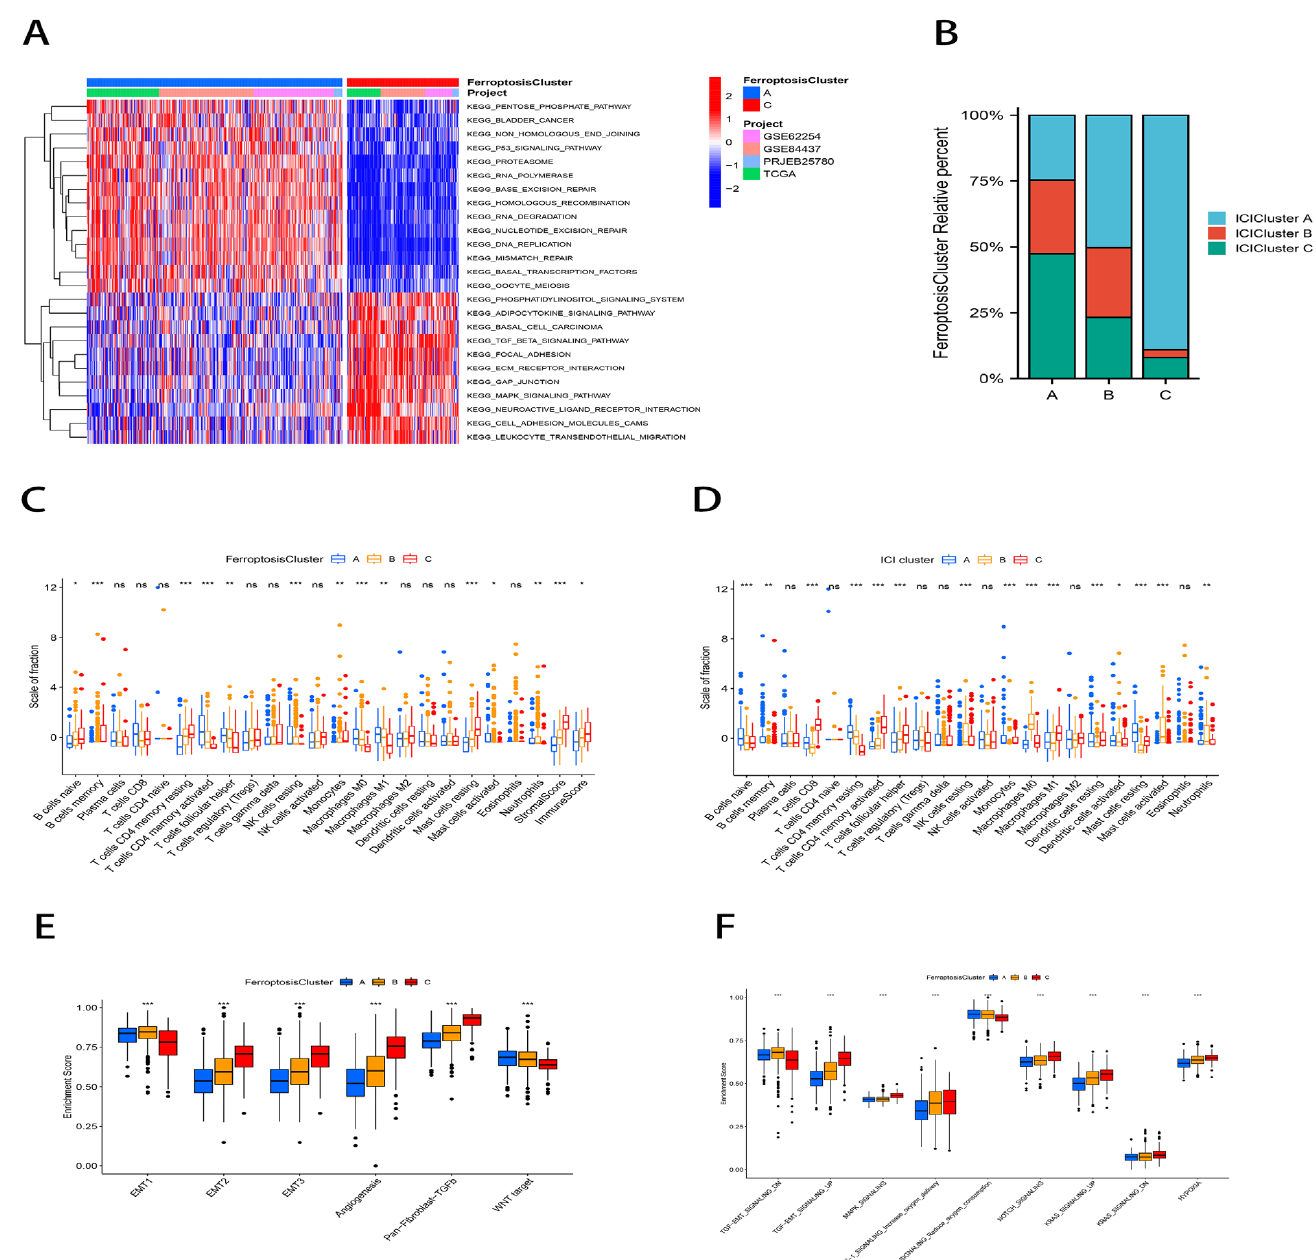
Figure 2. Tumor microenvironment characteristics of ferroptosis molecular subtypes. ( A ) GSVA analysis of distinct biological pathway activation in ferroptosis clusters A and C. Blue represents the repression pathway and red represents the activation pathway. ( B ) Percentage distribution of immune cell infiltration subtypes in each ferroptosis molecular subtype. ( C , D ) Box plots of immune infiltration levels in ferroptosis molecular subtypes ( C ) and immune cell infiltration subtypes ( D ). ns: not significant; * p < 0.05; ** p < 0.01; *** p < 0.001. ( E , F ) Differences in stromal activation pathway ( E ) and carcinogenesis-related pathways ( F ) in the three ferroptosis molecular subtypes. ns: not significant; * p < 0.05; ** p < 0.01; *** p <